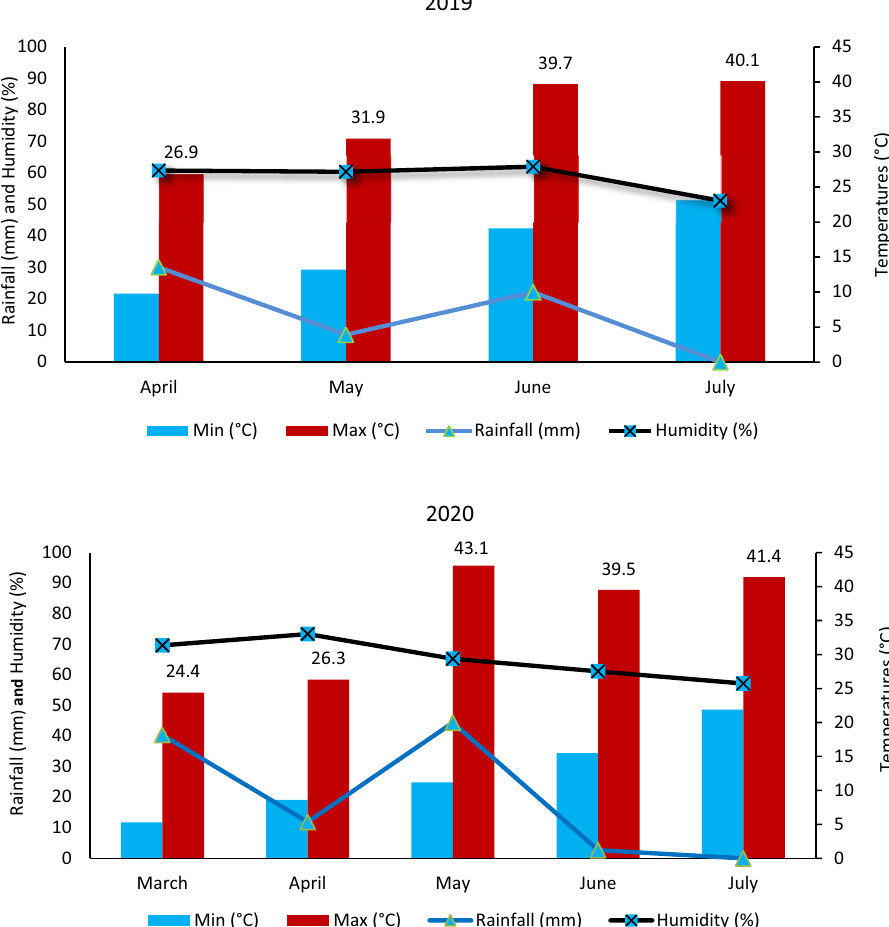
Figure 6. Monthly minimum and maximum temperatures, rainfall and relative humidity from sowing to harvest time in 2019 and 2020 growing